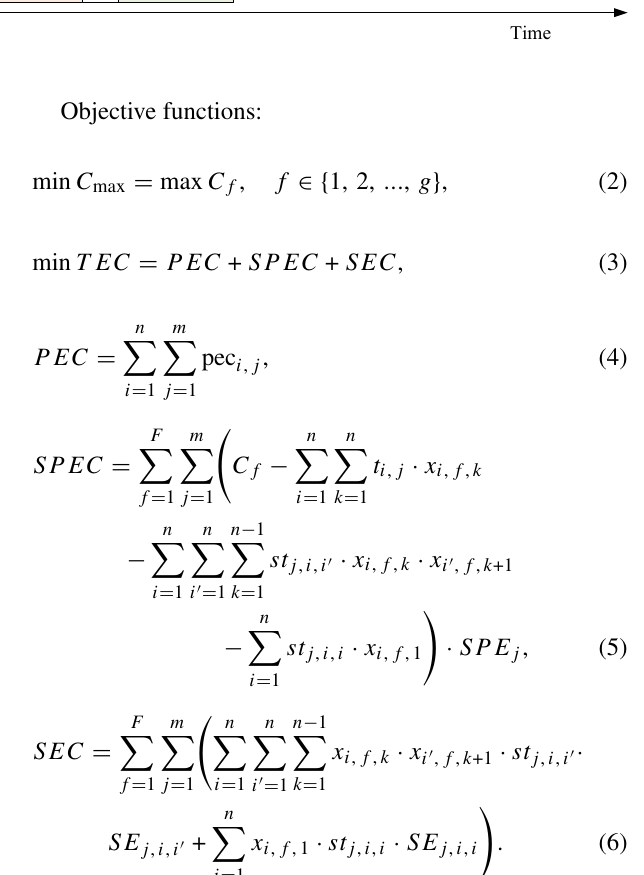
Fig. 1 Example of EEDNWFSP